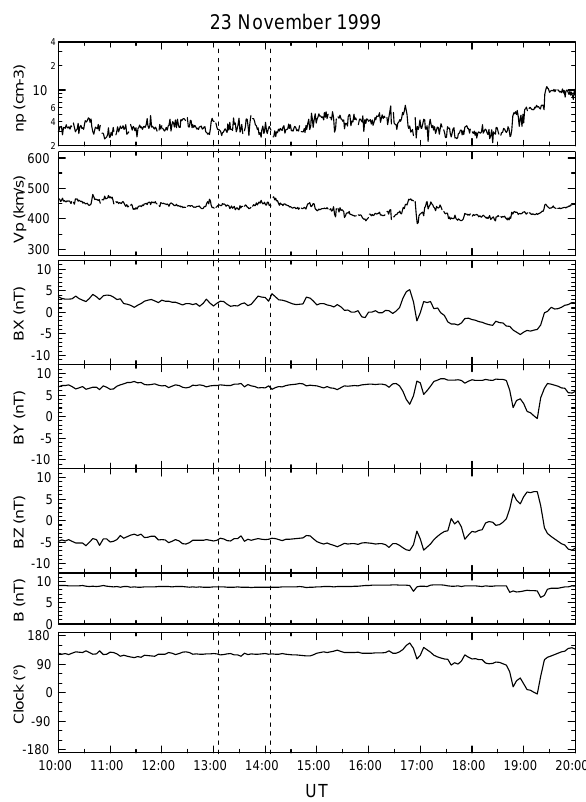
Fig. 4. Solar wind (proton) and interplanetary magnetic field data for 23 November 1999 from the ACE spacecraft. Vertical dashed lines show the period of time at ACE that corresponds to the solar wind at Earth during the 14:00–15:00 UT interval analyzed here.